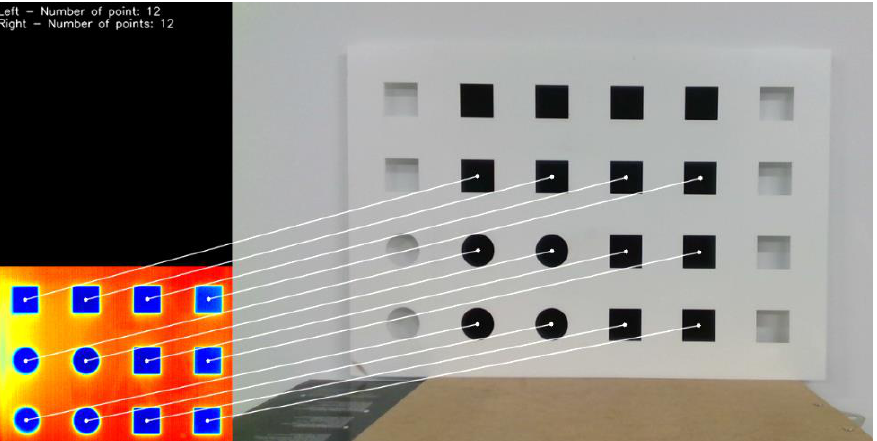
Figure 1. Custom built checkerboard keypoint detection and matching. ( Left ) Thermal image with the keypoints detected in the features of the checkerboard. ( Right ) RGB image with the keypoints detected in the features of the checkerboard. White lines show the corresponding thermal and visible keypoint pair. Notice the black aluminum plate behind the checkerboard in the RGB image and its corresponding cold contrast signature in the thermal image.